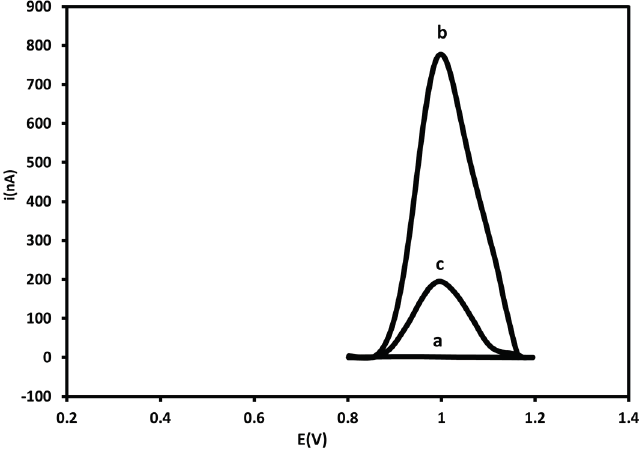
Figure 4. Differential pulse voltammograms corresponding to bare PGE ( a ), probe-modified PGE before ( b ) and after hybridization with 250 nM of target sequence ( c ) in 20mM Tris-HCl buffer solution (pH 7.0). Experimental conditions: Scanning potential range between +0.5 V and +1.2 V and scan rate of 0.05